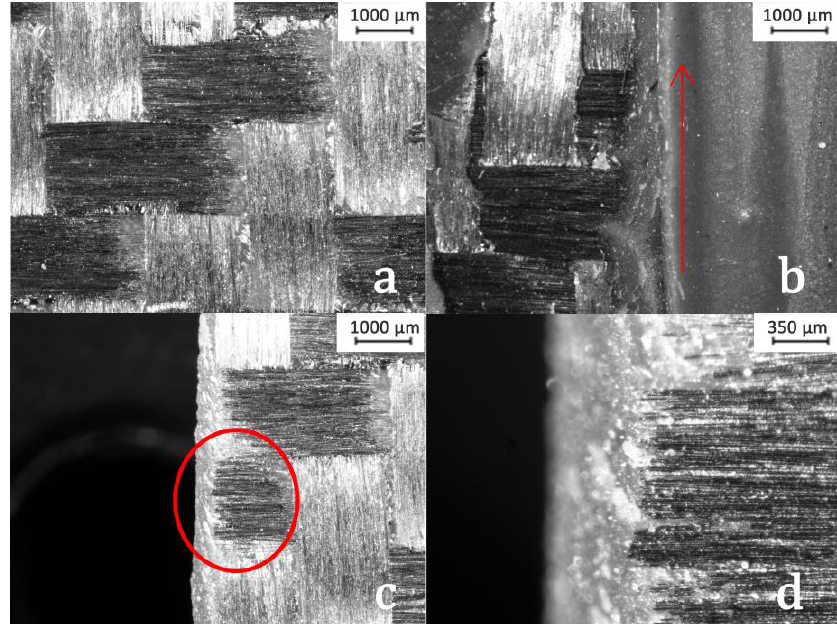
Figure 8. Fractographic analysis of SLS specimens. ( a ) Lack of Fiber / Matrix debonding; ( b ) Direction of cracking growth along the length of adhesive; ( c ) Fiber breakage; ( d ) Close in view of fiber breakage.